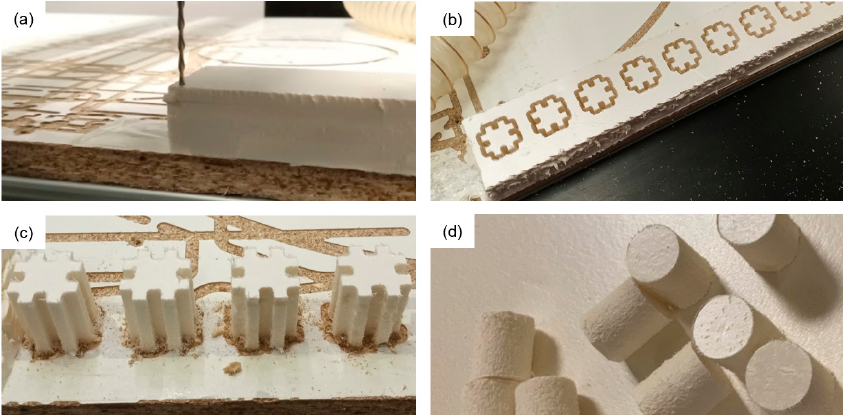
Figure 10. CNC cutting operation: ( a ) end mill, ( b ) array of fractal designs after cutting, and extraction of the ( c ) fractal and ( d ) circular columns.